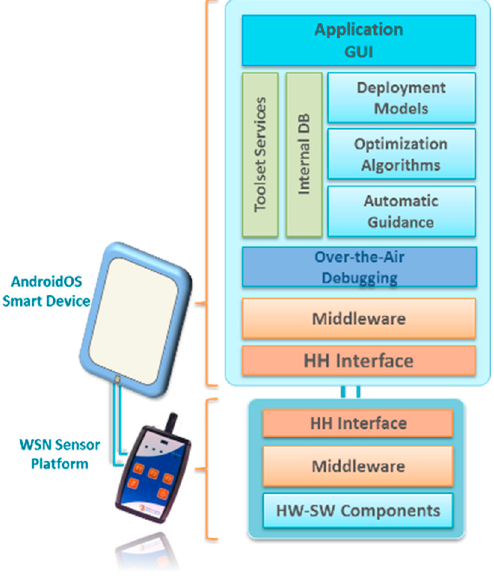
Figure 19. Overall HW-SW structure of the Hand-held device for the Commissioning and Maintenance